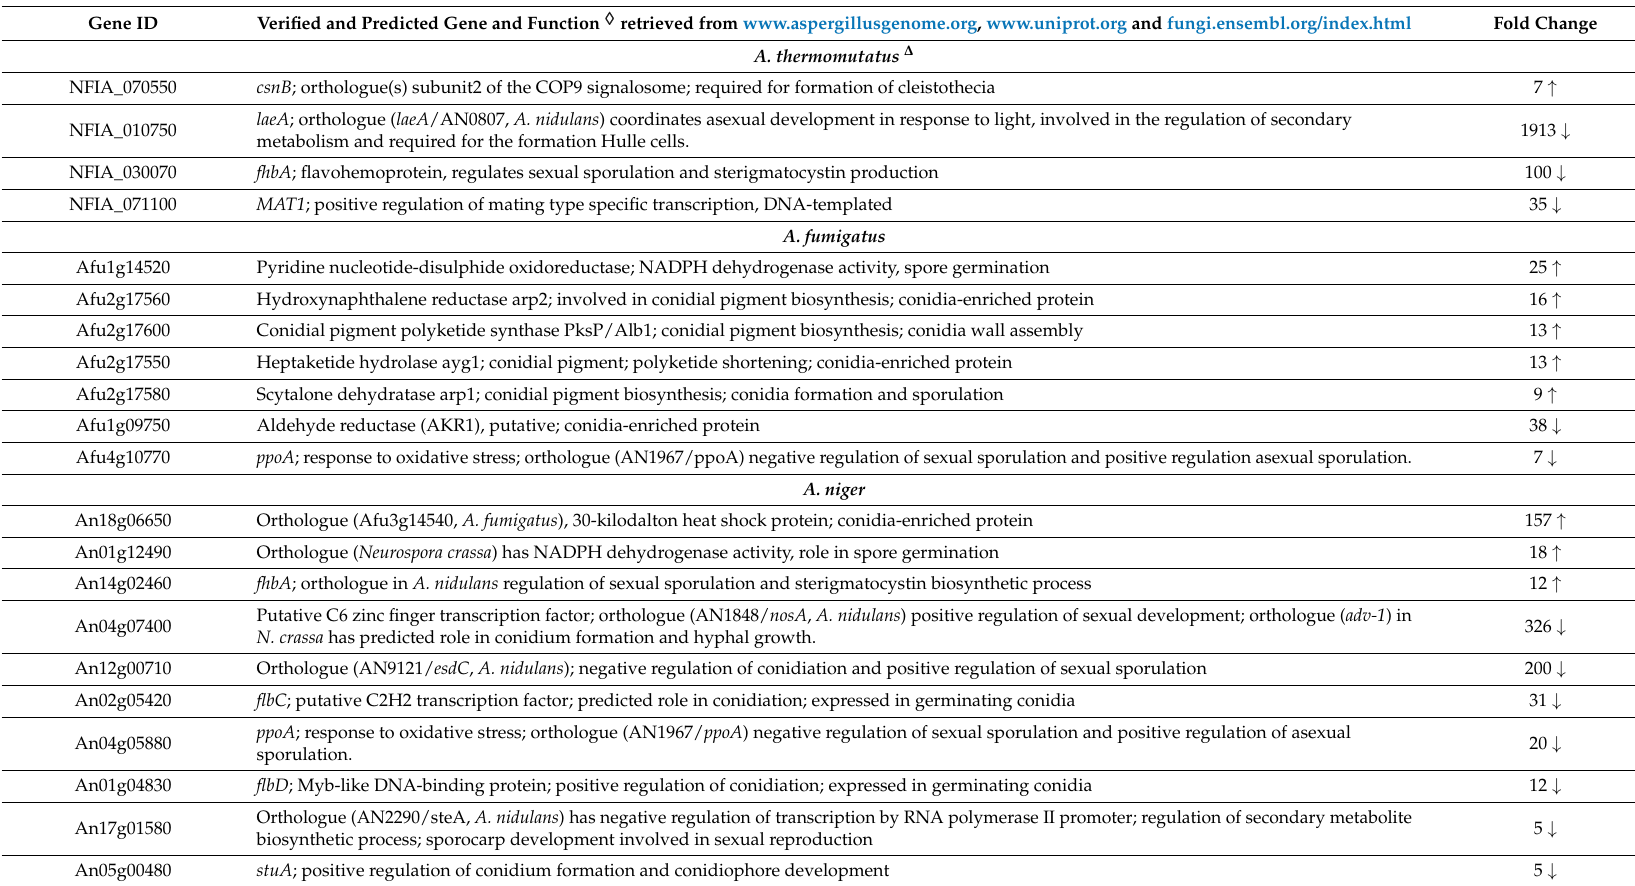
Table 2. Regulation of sporulation-related genes in AthCV1-infected Aspergillus species compared with their isogenic AthCV1-free line. Genes showing a five-fold or greater difference in expression between infected and non-infected lines are presented in the